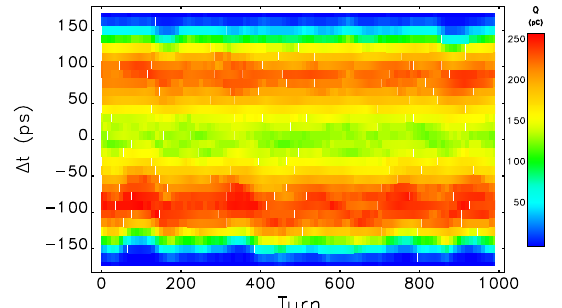
FIG. 15. Charge distribution over 1000 turns from 30-slice analysis for guard bunch 23 of a fill with twelve 2-bunch gaps.